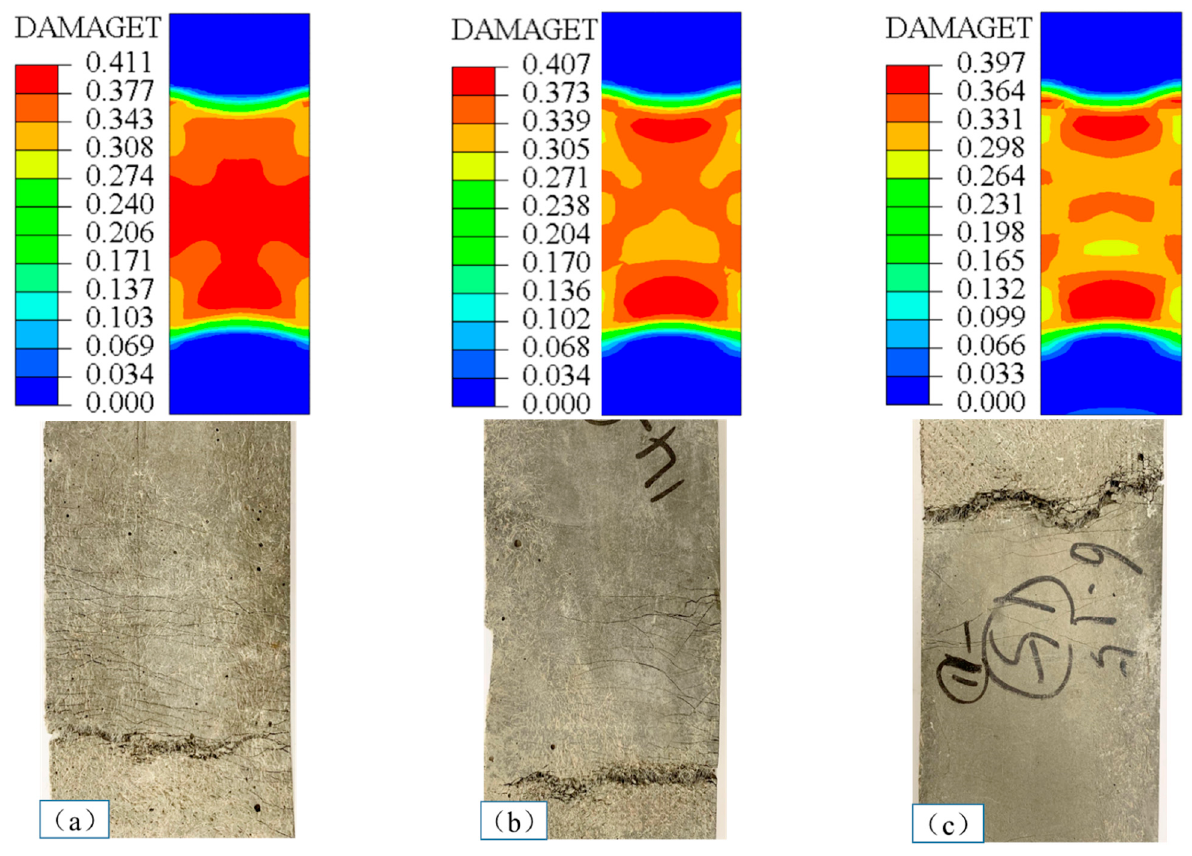
Figure 15. Failure modes for different enhancement rates in finite element simulations and tests: ( a ) 1.30%, ( b ) 2.70%, and ( c )